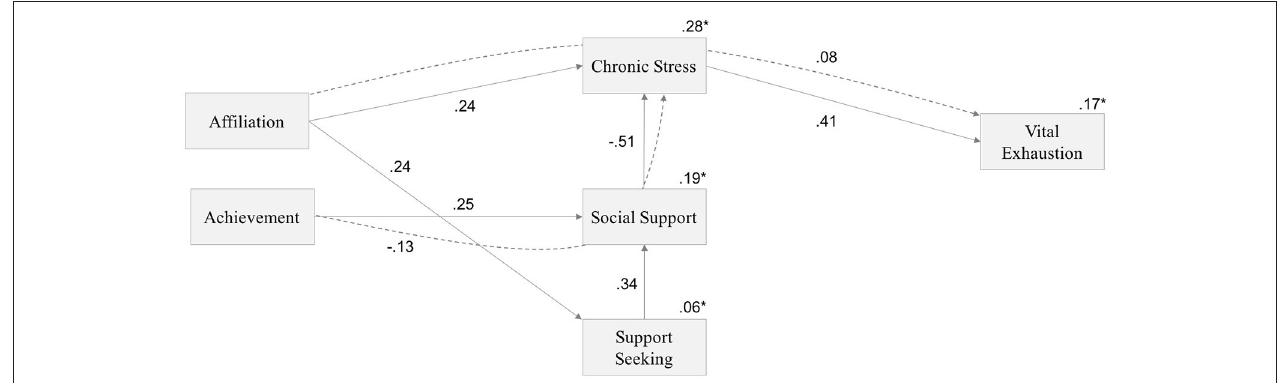
FIGURE 1 | Structural equation model showing direct and indirect relationships between implicit motives, support seeking, perceived social support, perceived chronic stress, and vital exhaustion. Solid arrows indicate direct effects. Dashed arrows show indirect effects of achievement on chronic stress through the mediator social support as well as the indirect effect of affiliation on vital exhaustion through the mediator chronic stress. Significant standardized regression coefficients are shown in the numbers adjacent to the arrows. Numbers with asterick represent variance explained.